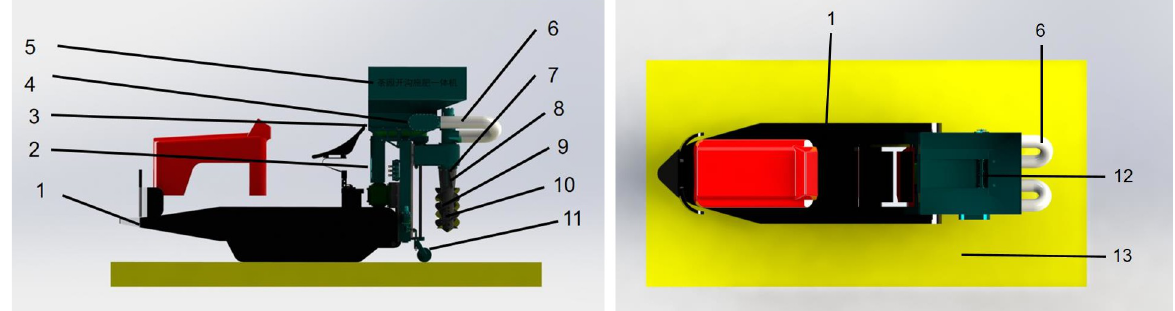
Fig 1. Structure of the double screw trencher and fertilizer. (a) Front view; (b) Top view. 1. tractor 2. drive shaft cover 3. fertilizer box frame 4. fertilizer discharge device 5. fertilizer box 6. fertilizer delivery pipe 7. scraper 8. trenching shaft 9. spiral blade 10. fertilizer discharge hole 11. profiled ground wheel 12. spiral fertilizer discharge device 13. tea garden.